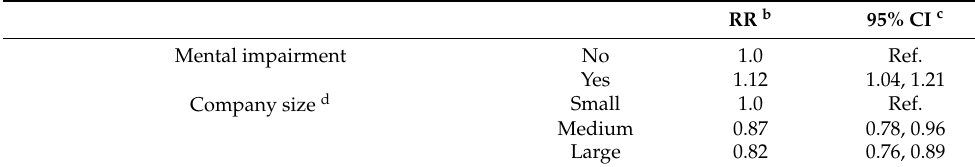
a Original labeling of operational integration management (OIM) in German: betriebliches Eingliederungsmanage- ment (BEM); b RR—risk ratio; c CI—confidence interval; d small—< 49 employees; medium—50–249 employees; large—250+